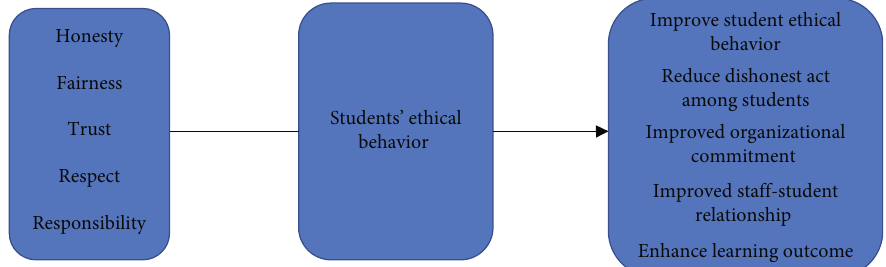
Figure 1: Conceptual framework of this